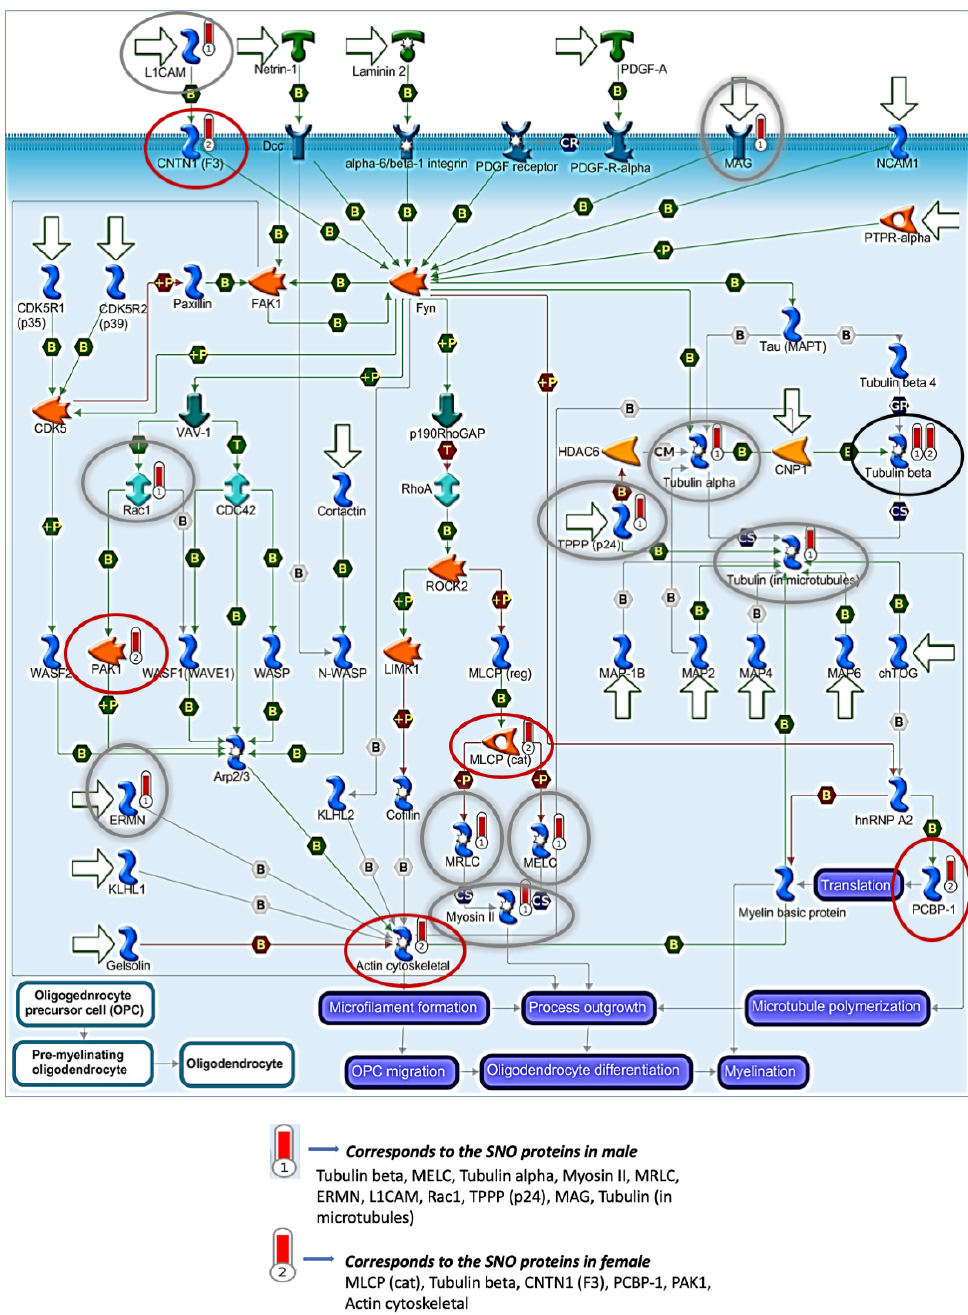
Figure 4. “Regulation of cytoskeleton proteins in oligodendrocyte differentiation and myelination“ pathway was enriched in both sexes. Red circles are SNO proteins in female. Gray circles are SNO proteins in male. Black circles are SNO proteins in both female and male.